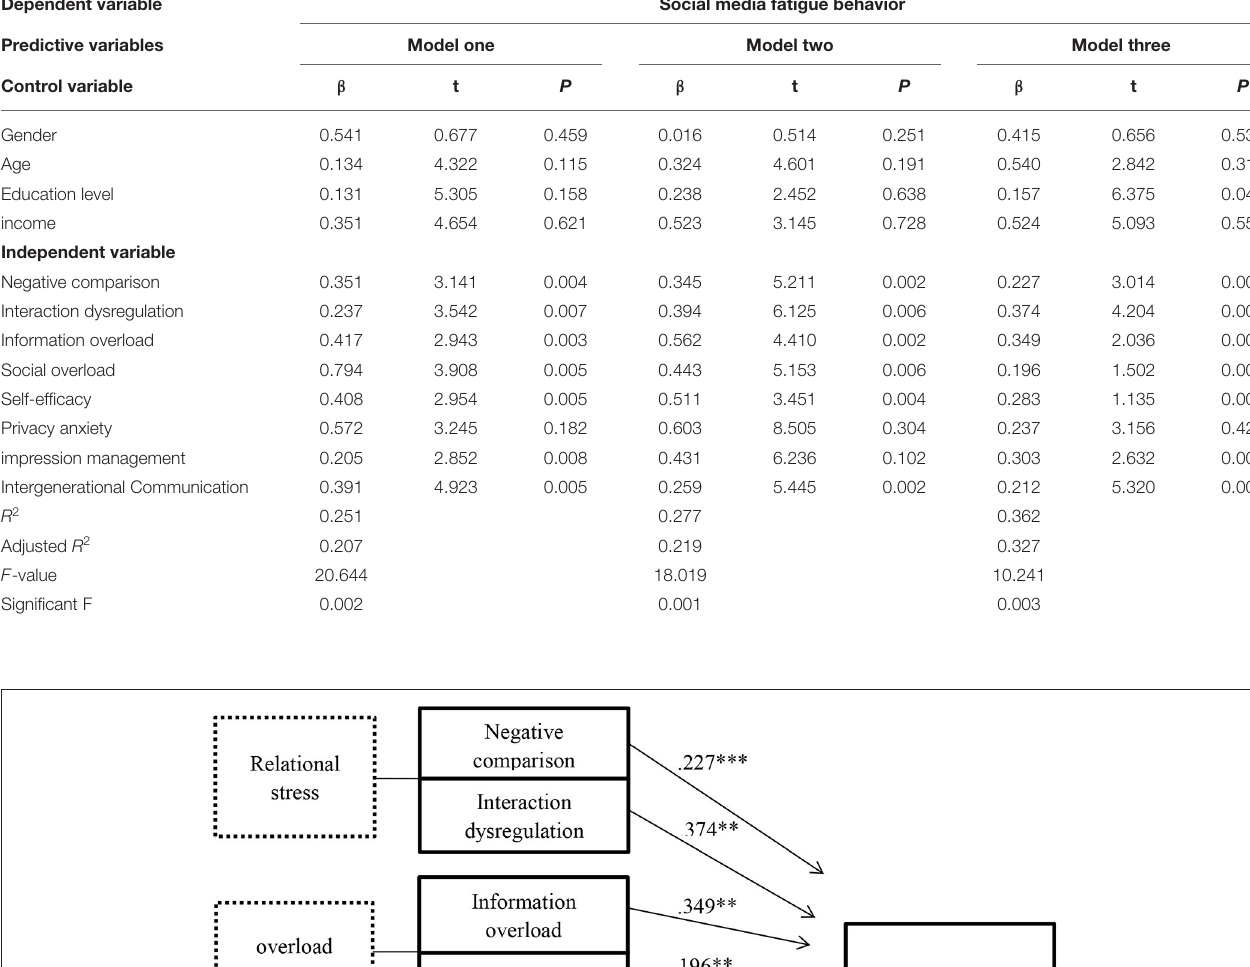
TABLE 4 | Regression analysis table.